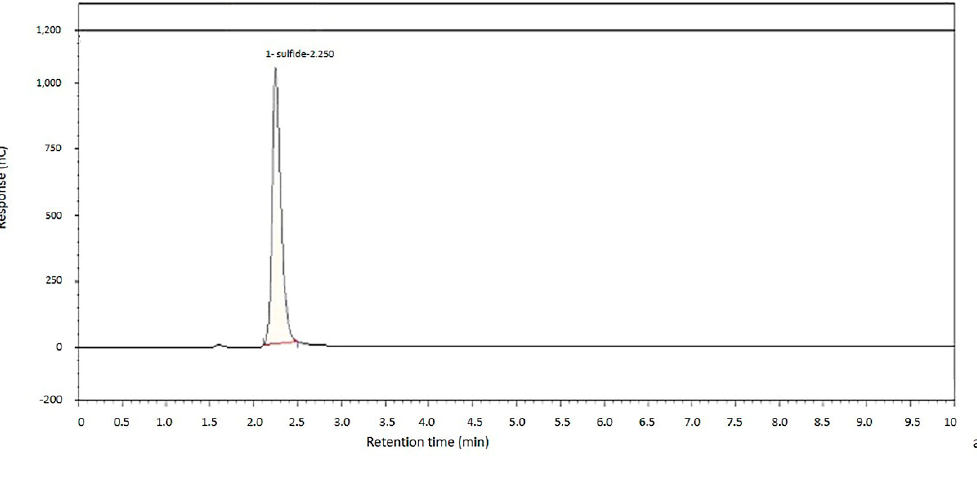
Figure 1. Chromatogram of both a standard ( a ) and a representative cerebrospinal fluid (CSF) ( b ), respectively, have been shown. The sample preparation described does not give any chromatographic interference with sulfide determination. Comparing both chromatograms, sulfide signal shows the exact retention time. The present IC method for the determination of sulfide has been optimized and val- idated internally for linearity, sensitivity, robustness, precision, accuracy, and repeatabil- ity. 2.2.1. Linearity The linearity was assessed by analyzing the detection signals as a function of the an- alyte concentration, with the aid of a regression line using the calibration curve method. All the correlation coefficients obtained ranged from 99.93 to 99.99% (R 2 ≥ 0.999). 2.2.2. Sensitivity The detection limit (limit of detection, LOD) and the quantitation limit (limit of quan- titation, LOQ) have been considered. These are two key parameters for determining whether an analyte is present in the sample and for testing the likelihood of false positive and negatives. As described in methods section, LOD and LOQ were calculated based on the standard deviation of the response (SD) and the slope of the calibration curve (S). In this study, LOD, calculated as 3 (SD/S) was 0.009 mg/L; LOQ, calculated as 10 (SD/S), was 0.028 mg/L. 2.2.3. Robustness To assess the robustness of the method, some analytical parameters were deliberately modified.